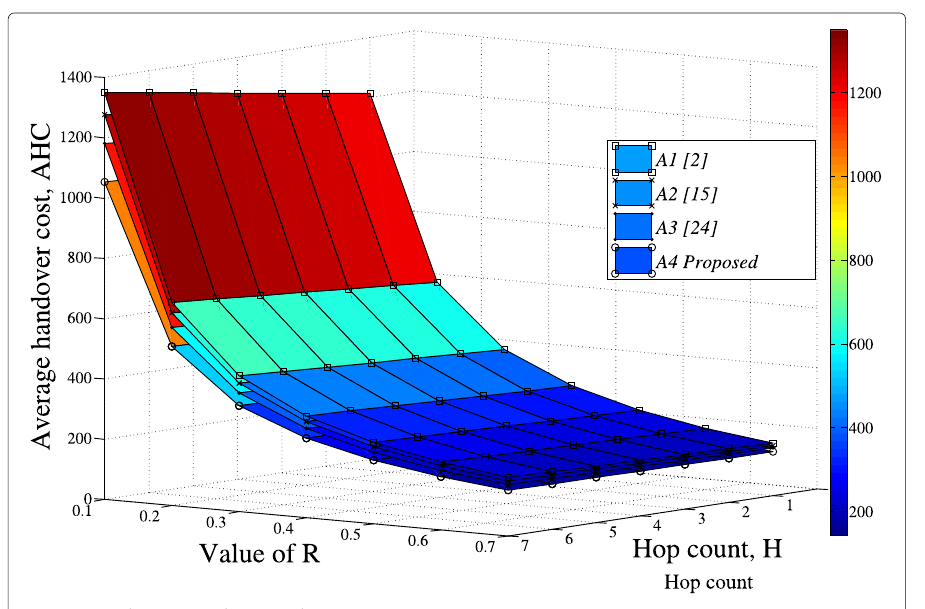
Fig. 21 Handover cost when R and H